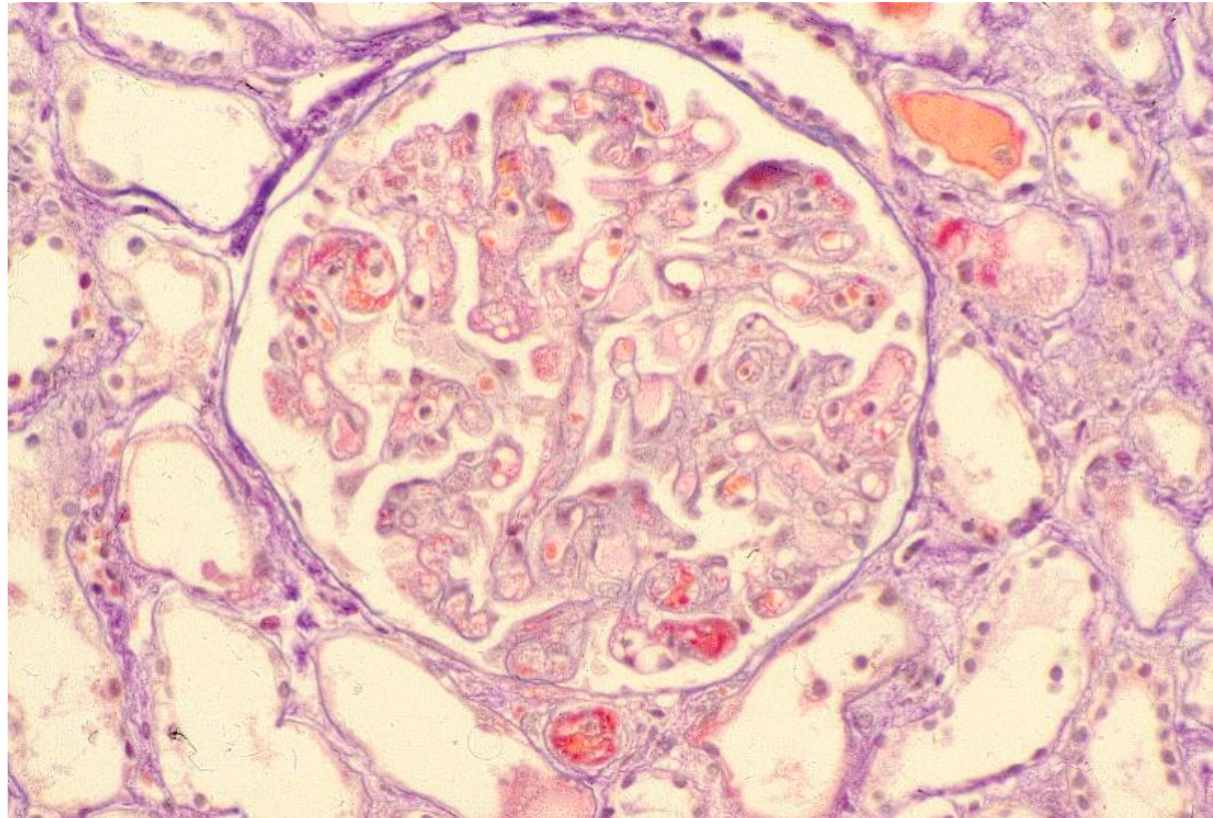
Figure 3. Light microscopy: ne glomerulus that shows fibrin thrombi of some capillary lumens, leukocytes infiltration, and a fibrin thrombus of the afferent arteriole.